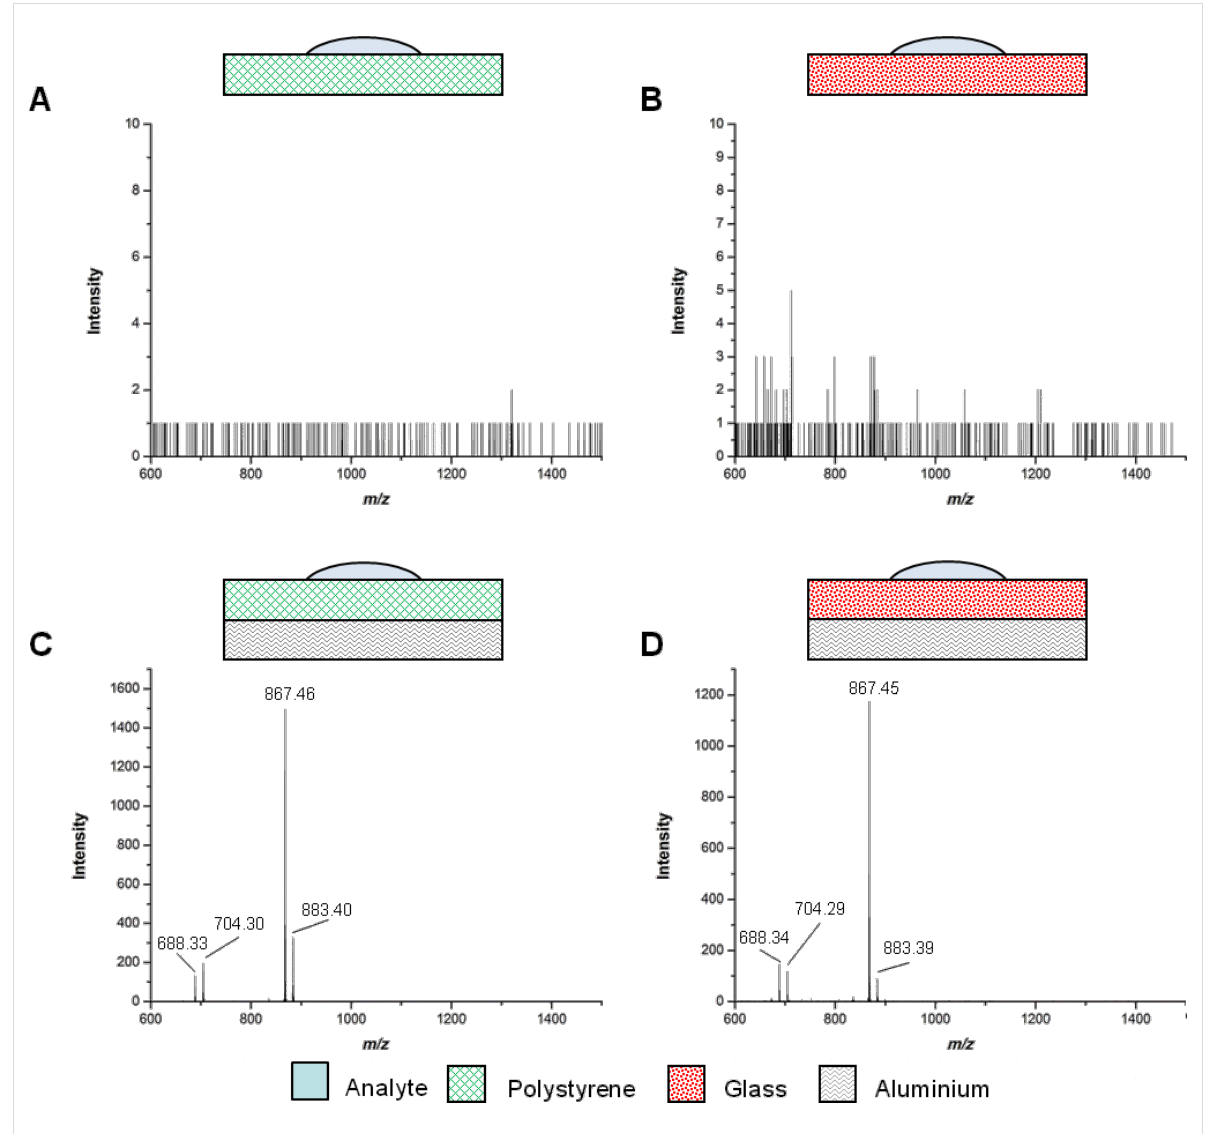
Figure 2: Comparison of the polystyrene and glass surfaces with and without aluminium backing by matrix-free MALDI-TOF MS analysis. Each spot contains 15 nmol Man–Trt ( 5 ): (A) polystyrene without aluminium; (B) glass without aluminium; (C) polystyrene with aluminium and (D) glass with aluminium. The peaks at m / z of 688.3, 704.3, 867.5 and 883.4 correspond to [ 5 + Na] + , [ 5 + K] + , [ 8 + Na] + , and [ 8 + K] + , respectively.